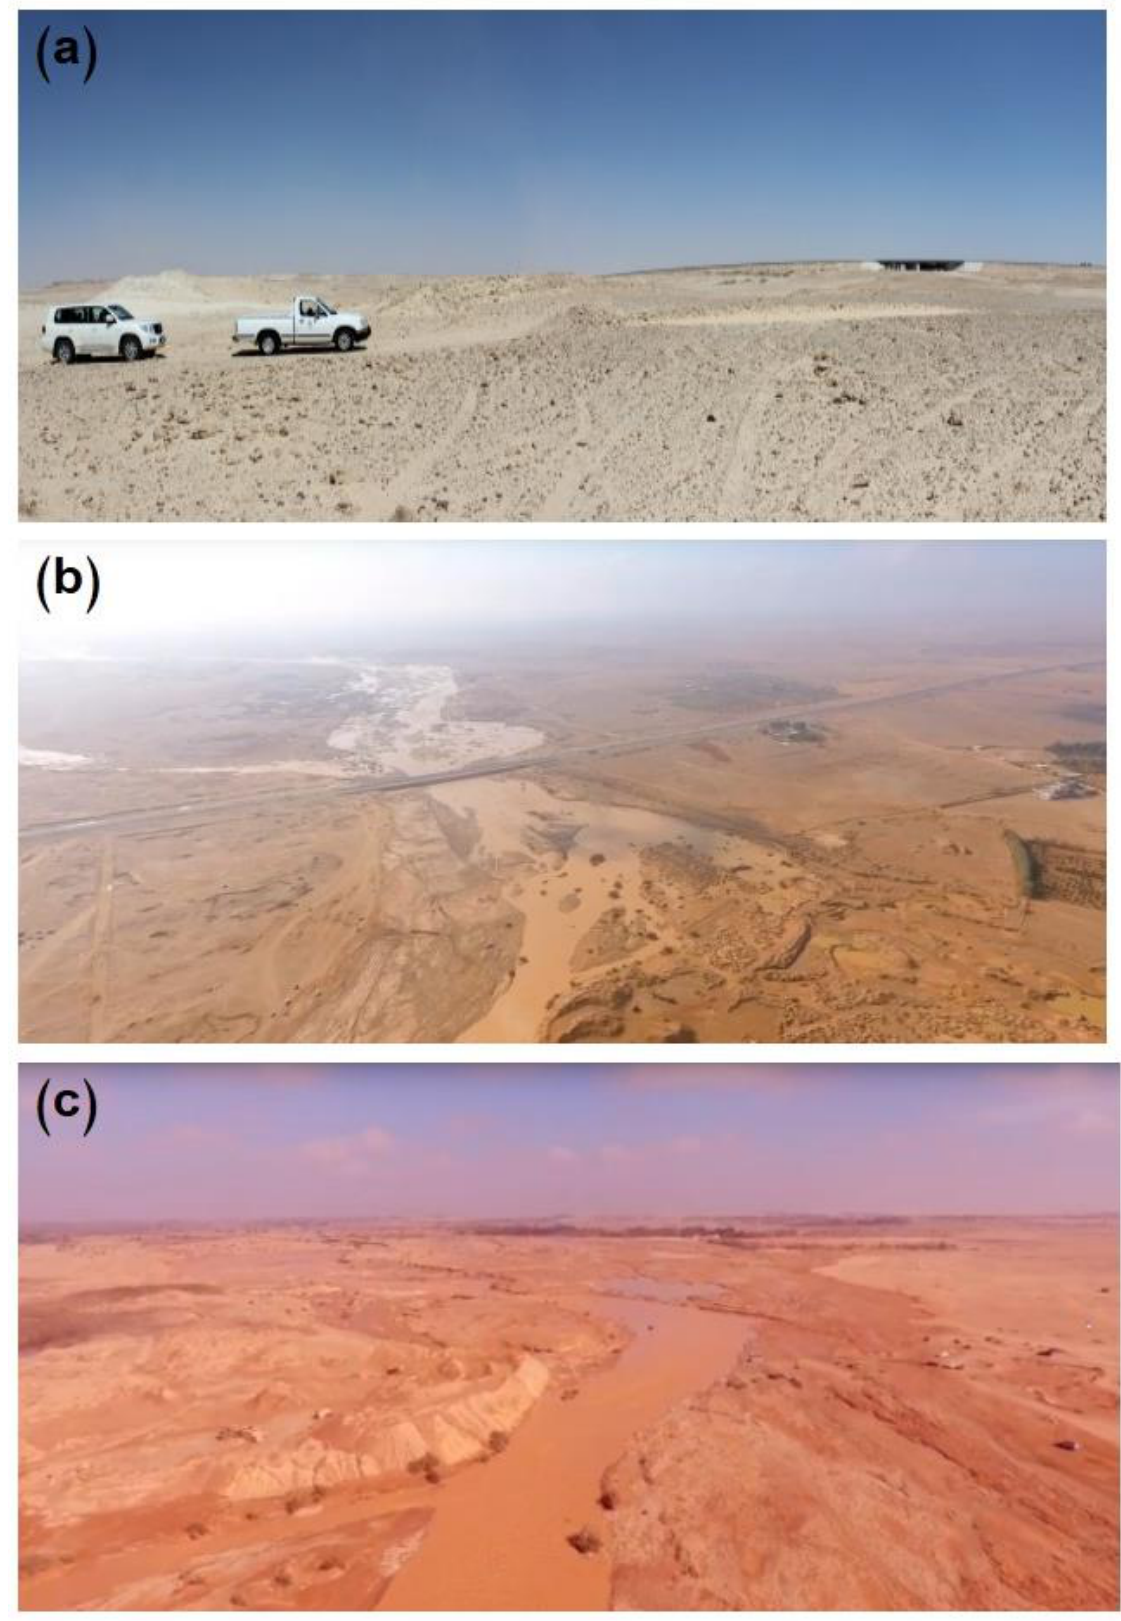
Figure 9. ( a ) Field visit to the area below the Al-Shamal train pathway in Al-Qurayyat city; and ( b , c ) Wadi Bayer during the floods on 10 November 2018.